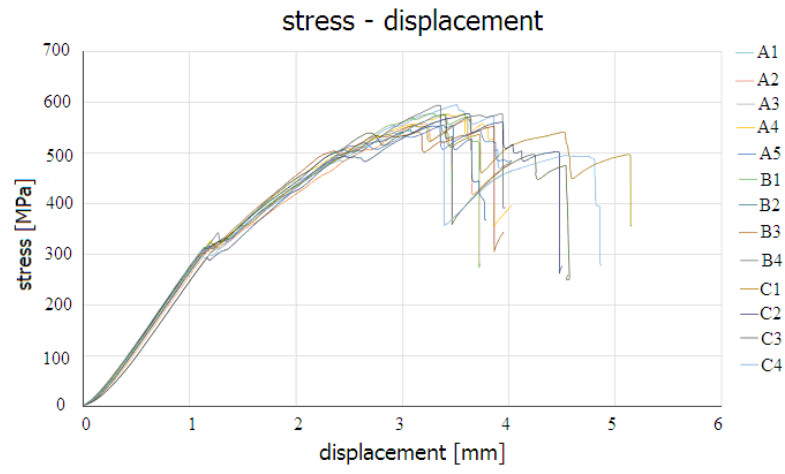
Figure 12. Mechanical characteristics of the 3-point bending test of all tested samples.